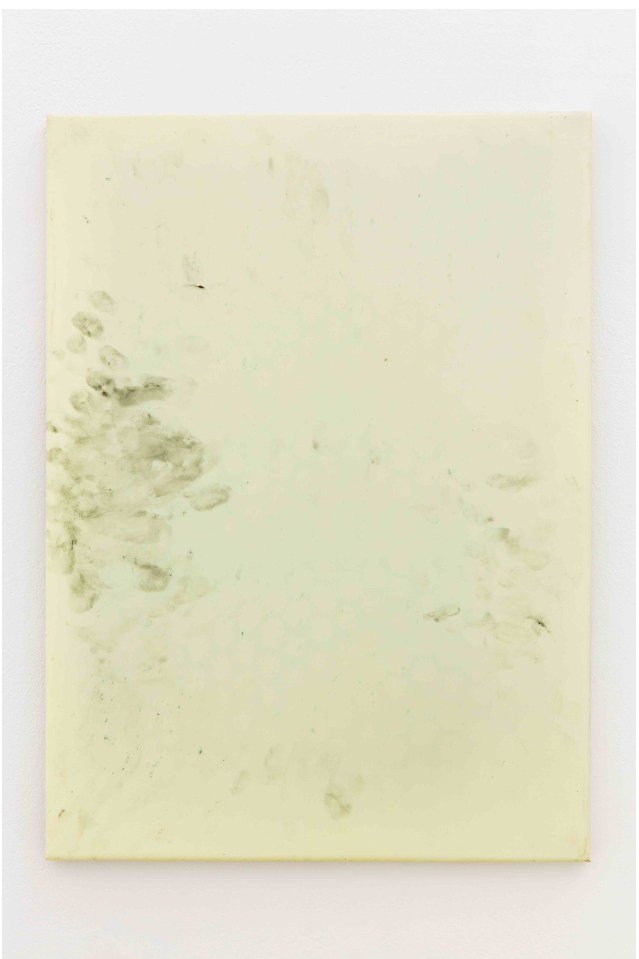
Figure 2: Damian Taylor, Untitled (paw) , 2016, Pigmented resin, glass fibre, hon- eycomb aluminium, 48 x 35cm. Untitled (pour) , 2016, Pigmented resin, glass fibre, honeycomb aluminium, 48 x